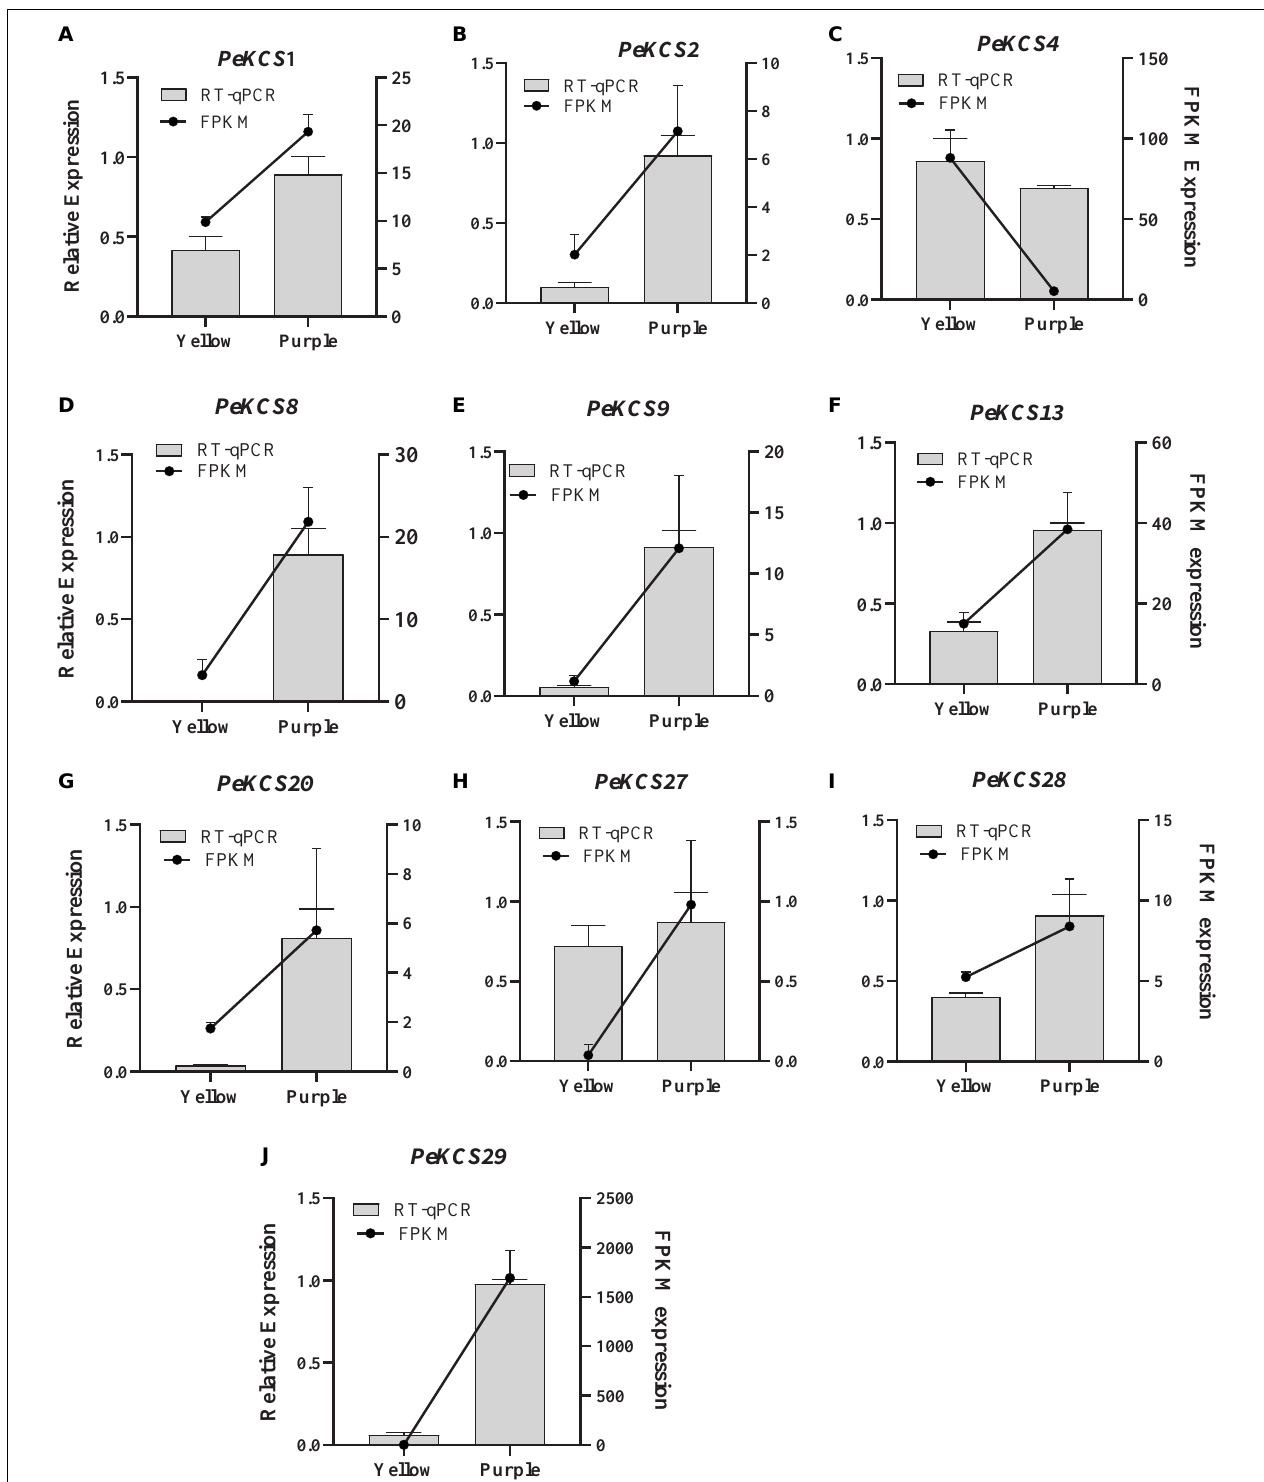
FIGURE 14 | Validation of RNA-seq expression data by qRT-PCR. Histograms show the qPCR results of 10 PeKCS genes in peel tissues of yellow and purple cultivars at ripening stage. Black line charts show the FPKM values of PeKCS genes on and vertical gray bars show the qPCR results (2 − (cid:49)(cid:49) ct ) and represents mean ± SD. The left Y -axis represents the relative expression levels by qPCR and the right Y -axis indicates the FPKM values of RNA-seq data.